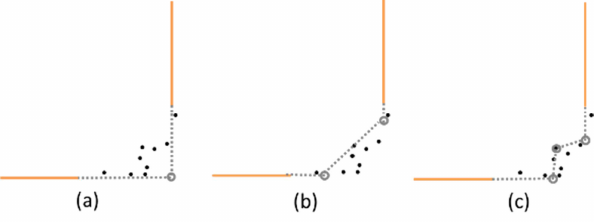
Figure 5. Connector hypotheses: (a) no additional line; (b) one additional line and (c) two additional